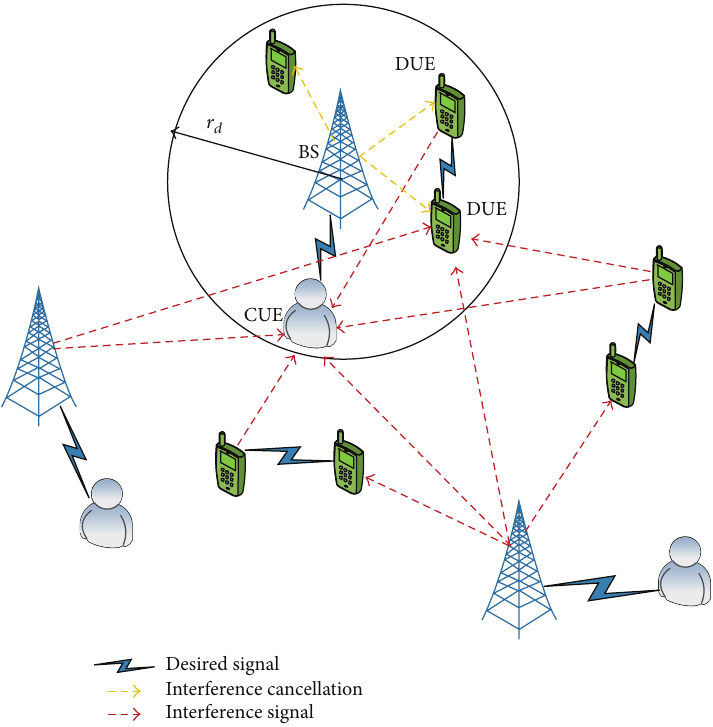
Figure 1: Cellular and D2D communication model. 𝑟 𝑑 is interference cancellation radius in interference cancellation